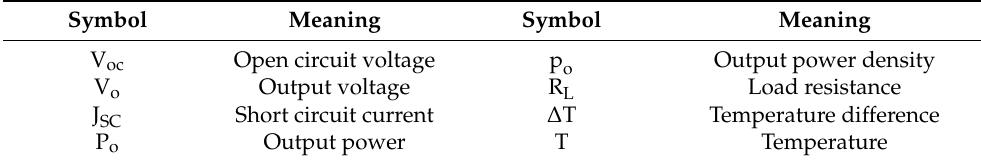
Table 1. Parameters in this article.